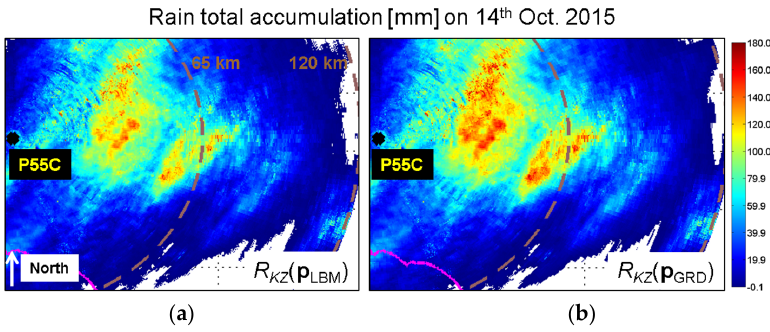
Figure 7. Zoomed rain accumulation map within 24 h from Polar 55C radar using R KZ ( p LBM ) ( a ); and R KZ ( p GRD ) ( b ) on 14 October 2015.